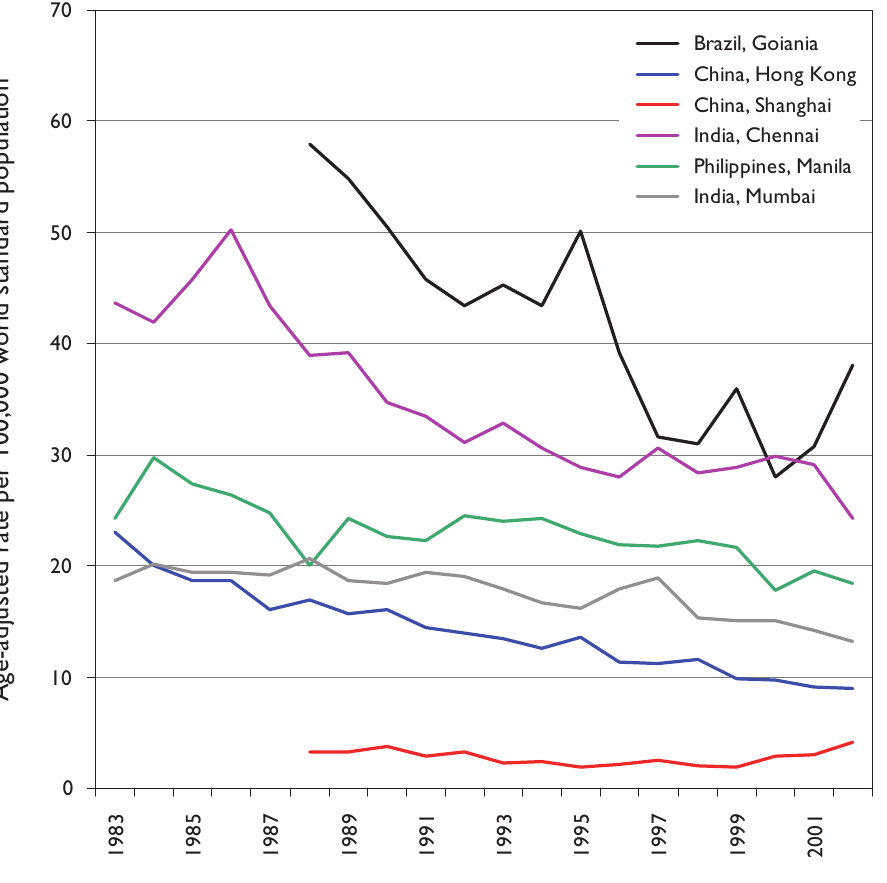
Figure 2. Trend in Cervical Cancer Incidence Rates in Selected Countries, 1983-2002